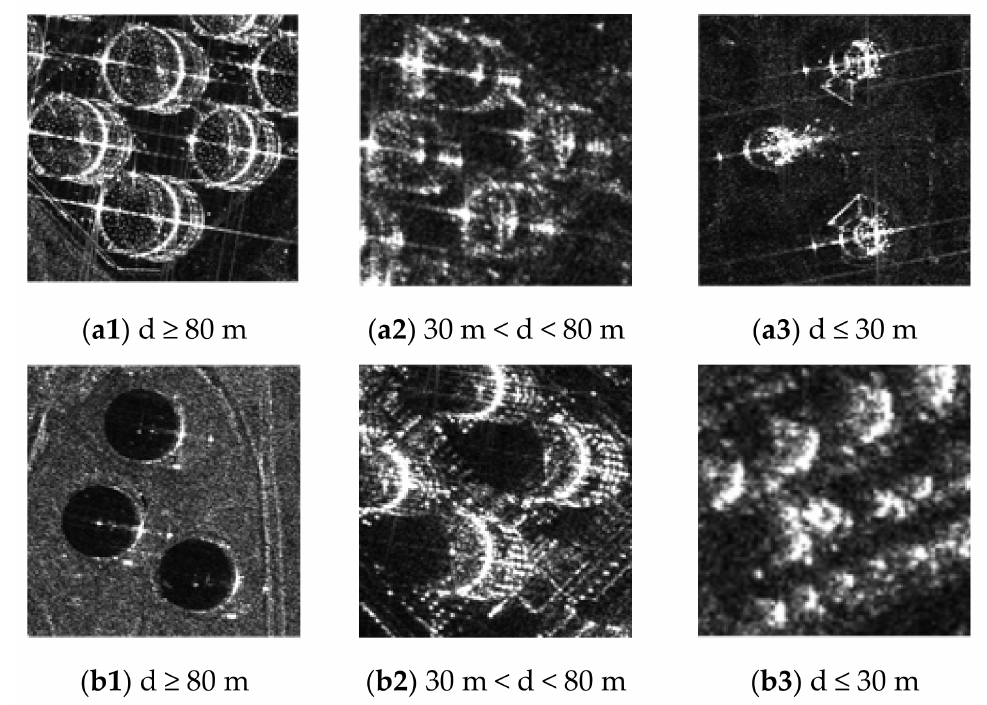
Figure 2. ( a1 – a3 ) The appearance of floating-roof tanks in different diameters of GF-3 1 m SAR images; ( b1 – b3 ) The appearance of fixed-roof tanks in different diameters of GF-3 1 m SAR